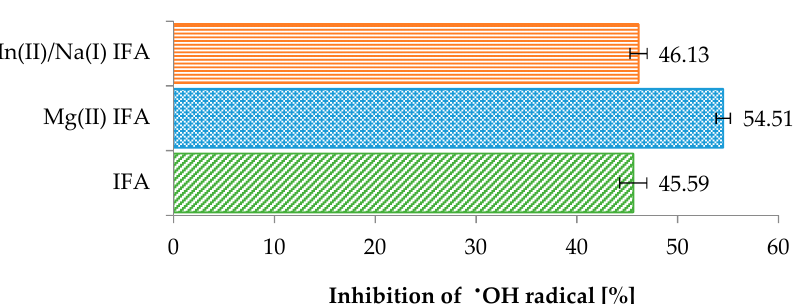
Figure 6. A comparison of the antioxidant activities of tested compounds (0.5 mM) measured by hydroxyl radical scavenging assay.